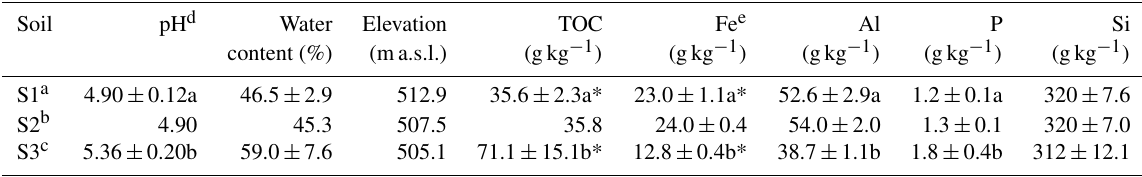
Table 1. General soil characteristics and concentrations (gkg − 1 soil) of total organic carbon (TOC), total Fe, Al, P, and Si in bulk S1 (Cambisol), S2 (Stagnic Cambisol), and S3 (Stagnosol). The lowercase letters indicate significant differences among soil sites (significant difference of soil site 1 and 3 was tested by t test; p < 0.05).